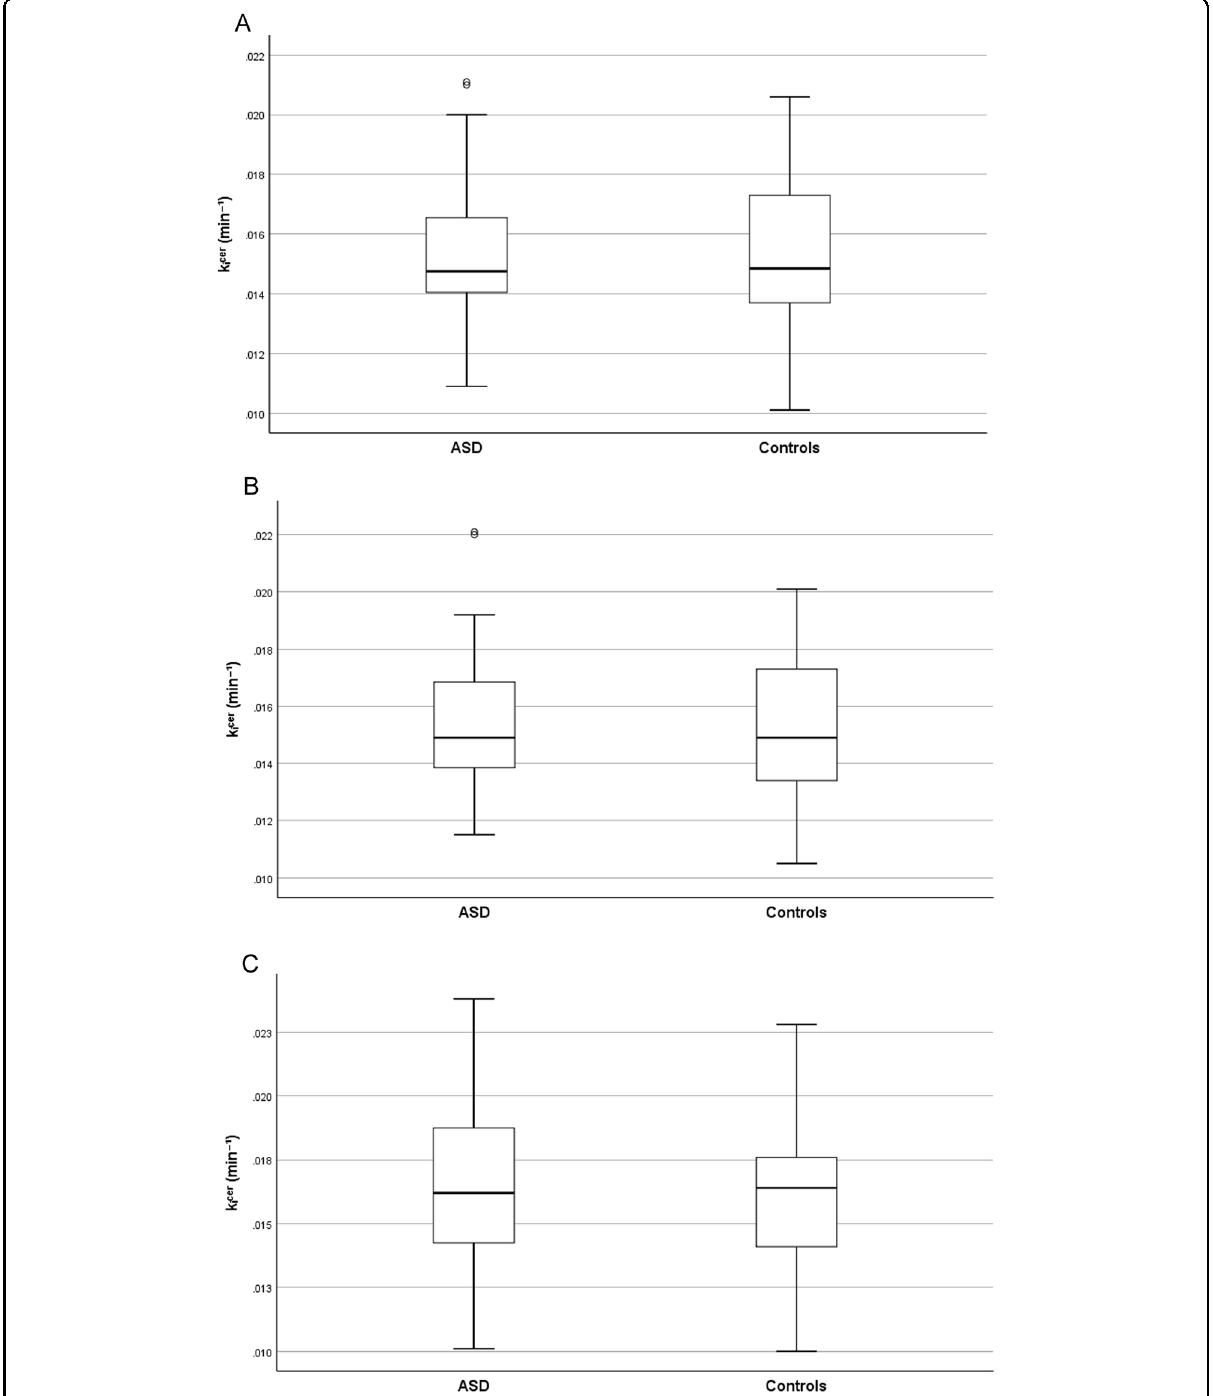
Fig. 2 Dopamine synthesis capacity in striatal sub-regions in adults with autism spectrum disorder (ASD) and controls. Boxplots show the median, quartiles, and range of presynaptic dopamine synthesis capacity ( k i cer min -1 ) in the A associative, B limbic, and C sensorimotor